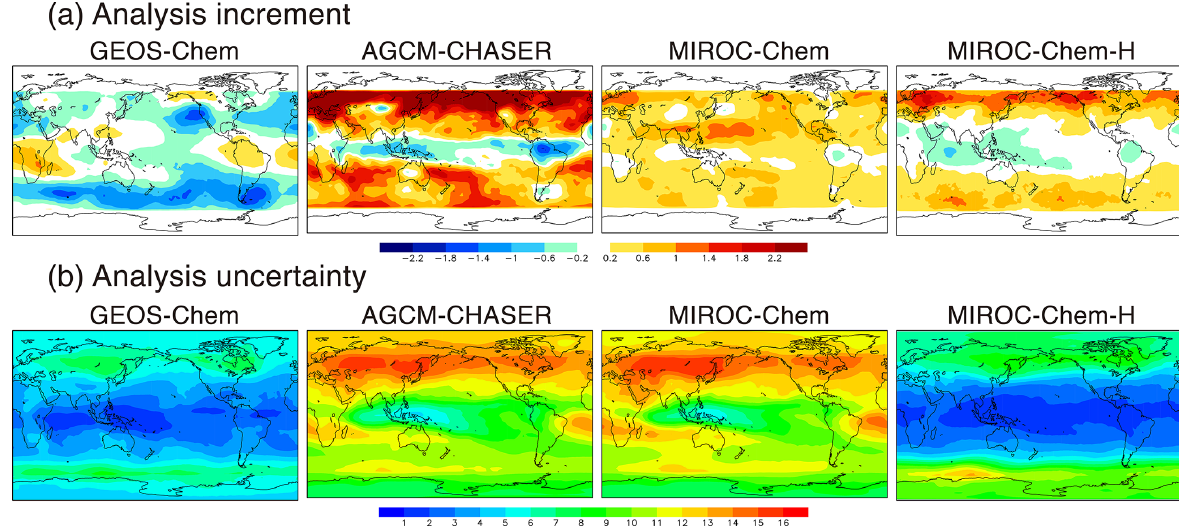
Figure 2. Spatial distributions of (a) analysis increment (ppbvd − 1 ) and (b) analysis uncertainty (ppb) of ozone at 500hPa averaged over 2007 from the four